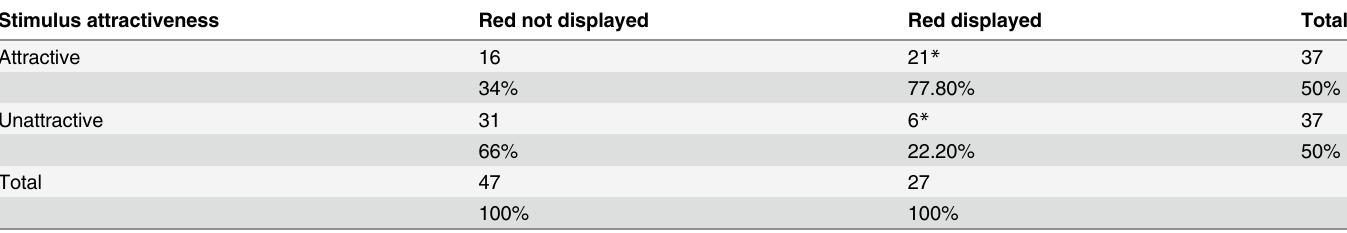
Table 1. Red display of women in the unattractive and attractive experimenter